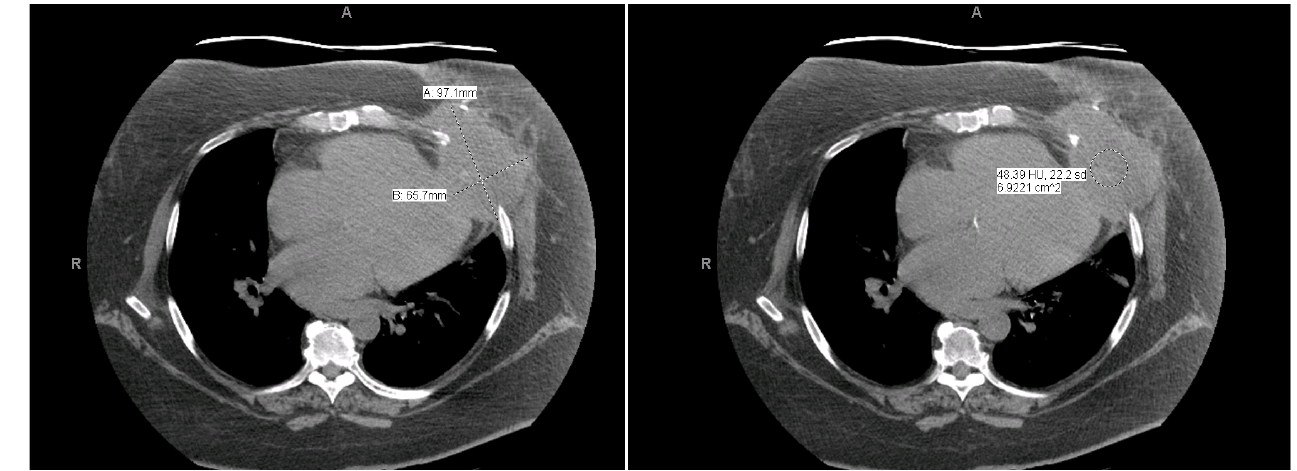
Figure. LVI-CT of the chest without